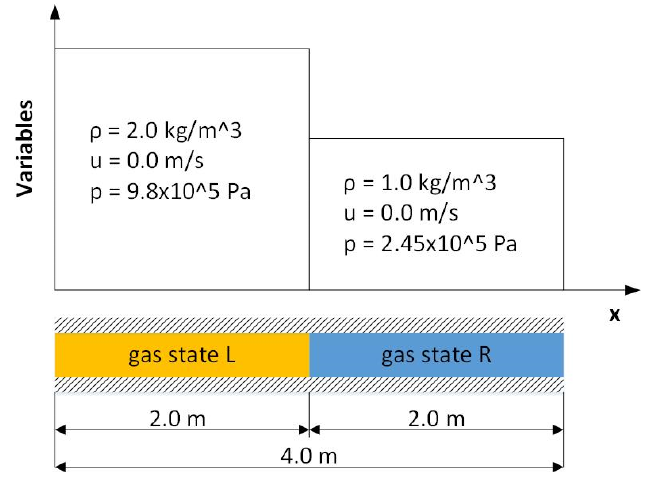
Figure 8. ICs of Case 1.